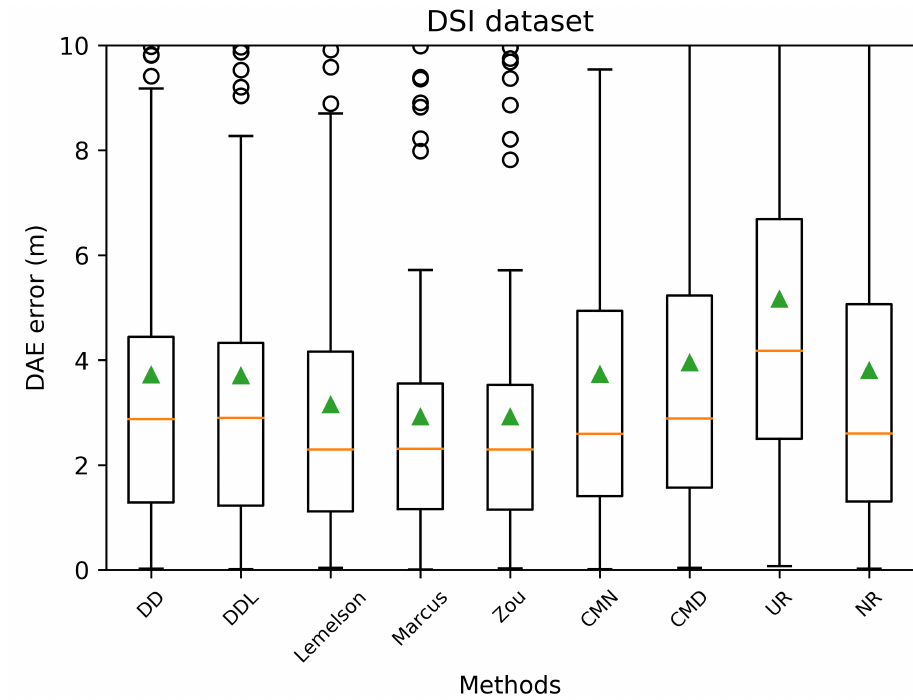
Figure 15. Boxplots indicating the distribution of the absolute DAE error of all studied methods and baselines, in the validation set of the DSI dataset. The green triangles indicate the mean values while outliers are depicted as black circles.